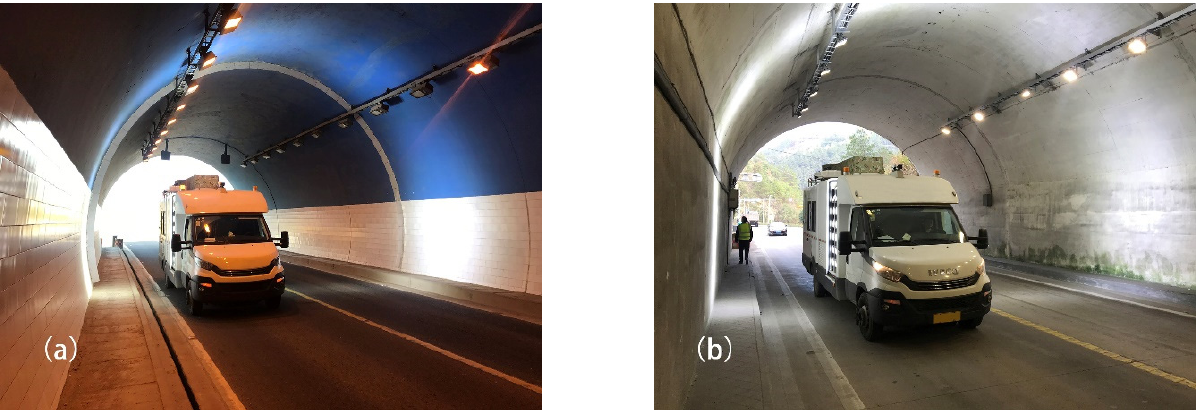
Figure 12. Tunnel inspection vehicle to carry out image collection ( a ) in the Shiziling tunnel, and ( b ) in the Zhaitouling tunnel.